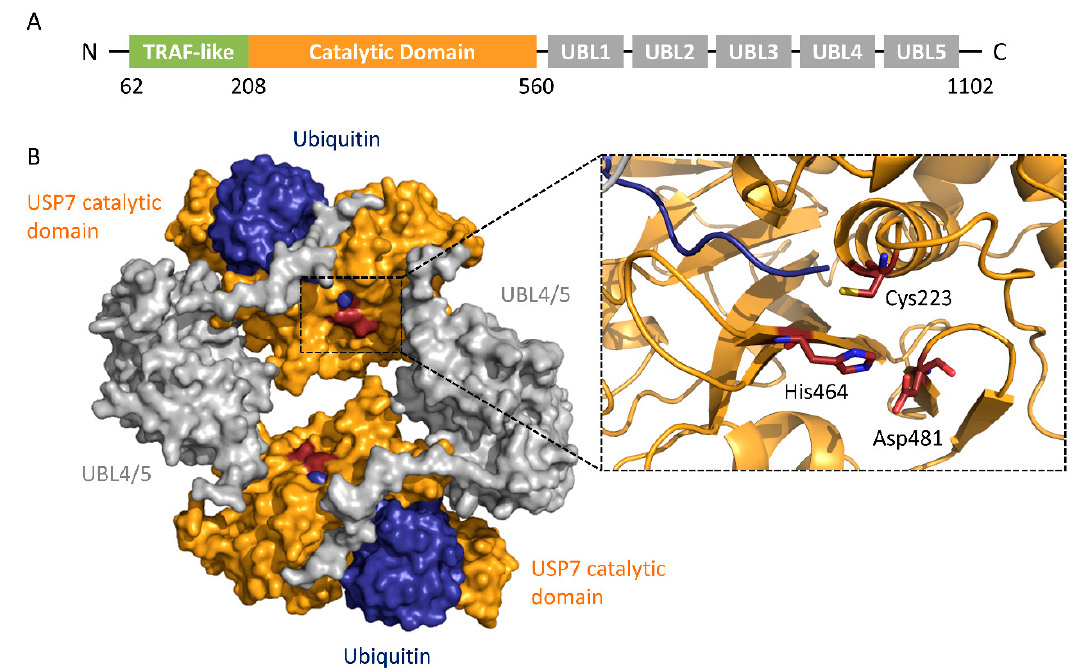
Figure 2. Structure of USP7. ( A ) Schematic of the USP7 domain organization [27]. ( B ) Crystal structure of the dimer of the USP7CD-UBL4/5-ubiquitin complex (PDB ID: 5JTV). Ubiquitin: blue; USP7 catalytic domain: orange; UBL4/5: gray. In this structure, the USP7 N-terminal TRAF-like domain and ubiquitin-like (UBL) domains 1–3 were truncated. The catalytic triad of USP7 (Cys223-His464-Asp481) was shown as red sticks.